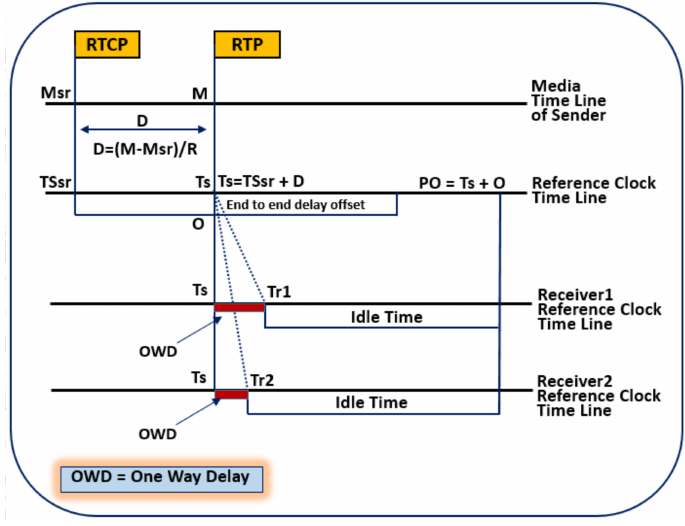
Figure 8. A detailed overview of the proposed